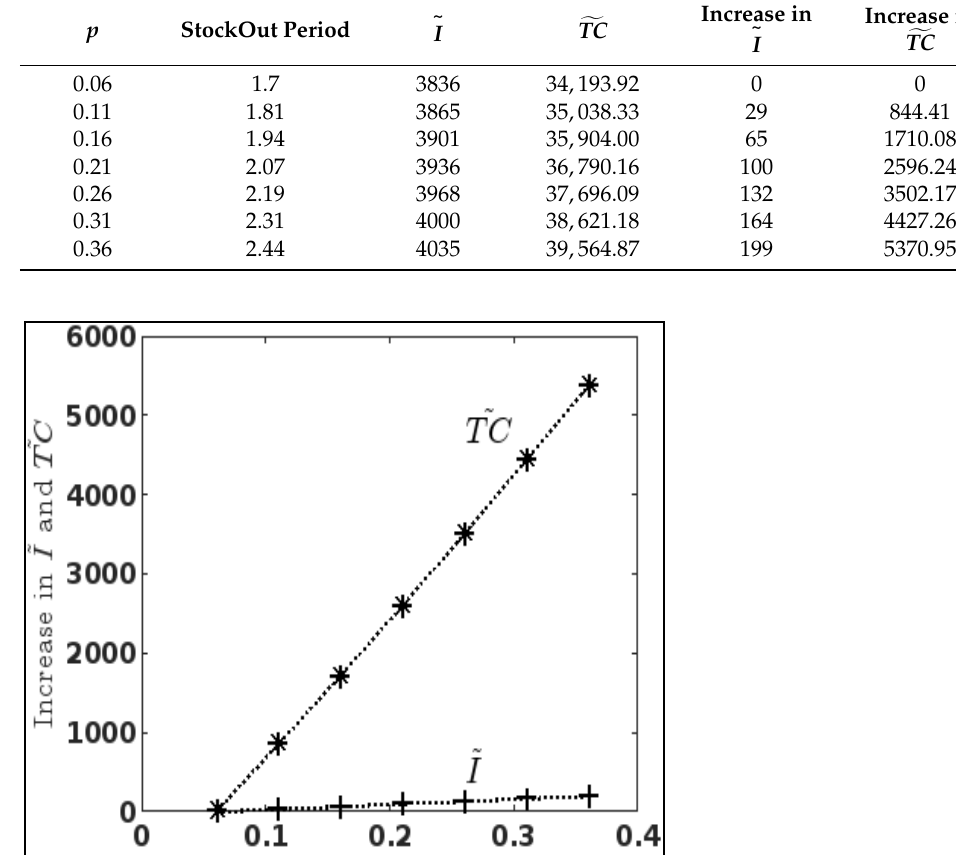
Table 4. Effect of penalty upon late payment of purchasing cost on optimizing the total cost.